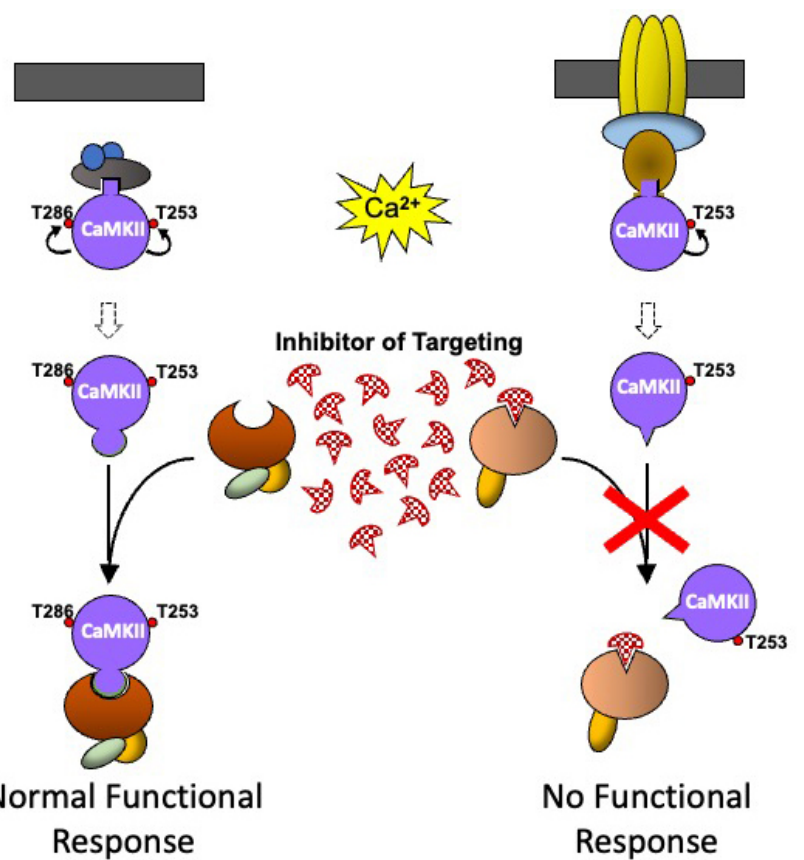
Figure 5. A schematic representation of how pharmacological agents that inhibit CaMKII targeting could be used therapeutically. As CaMKII that is phosphorylated at different sites binds to different binding proteins to produce different functional responses, an inhibitor that specifically blocks the interaction of CaMKII with a particular binding partner will inhibit a specific functional response, while leaving all the other pools of CaMKII bound to other binding proteins, untouched, and able to produce their normal functional response. Coloured oblong shapes represent generic proteins with which CaMKII (purple disc) binds directly or indirectly. Dark grey bar represents a membrane. Geometric protrusions from CaMKII, and indents in the binding proteins represent binding sites for CaMKII. The small red disc represents the phosphorylation of a protein. See text for explanation of the sequence of events shown in the